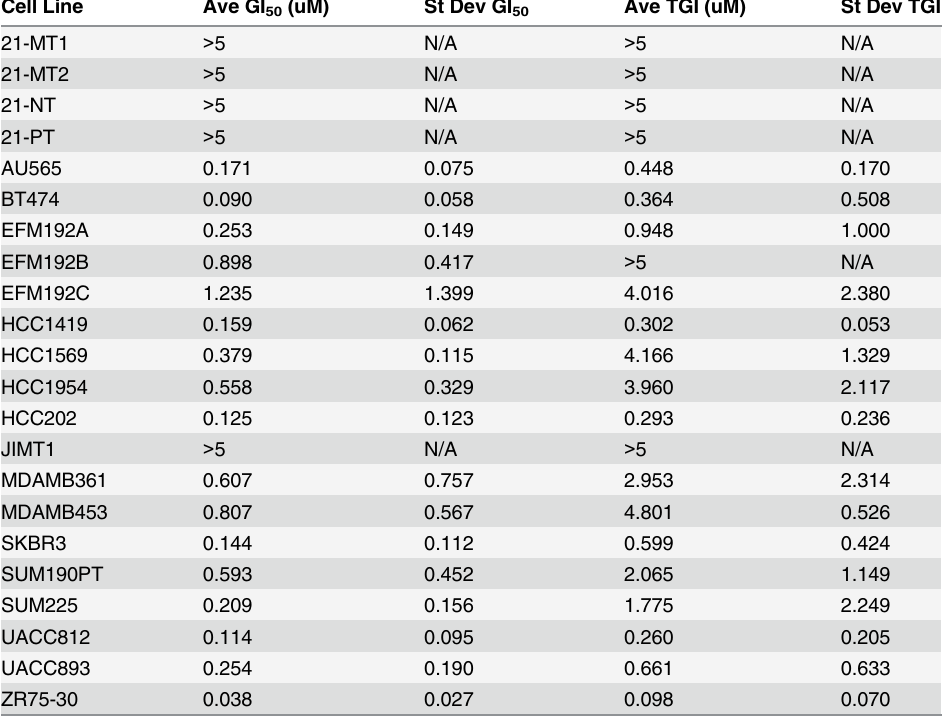
Table 1. Average GI 50 and TGI values for lapatinib in 22 HER2 positive breast cancer cell lines. Cell Line Ave GI 50 (uM) St Dev GI